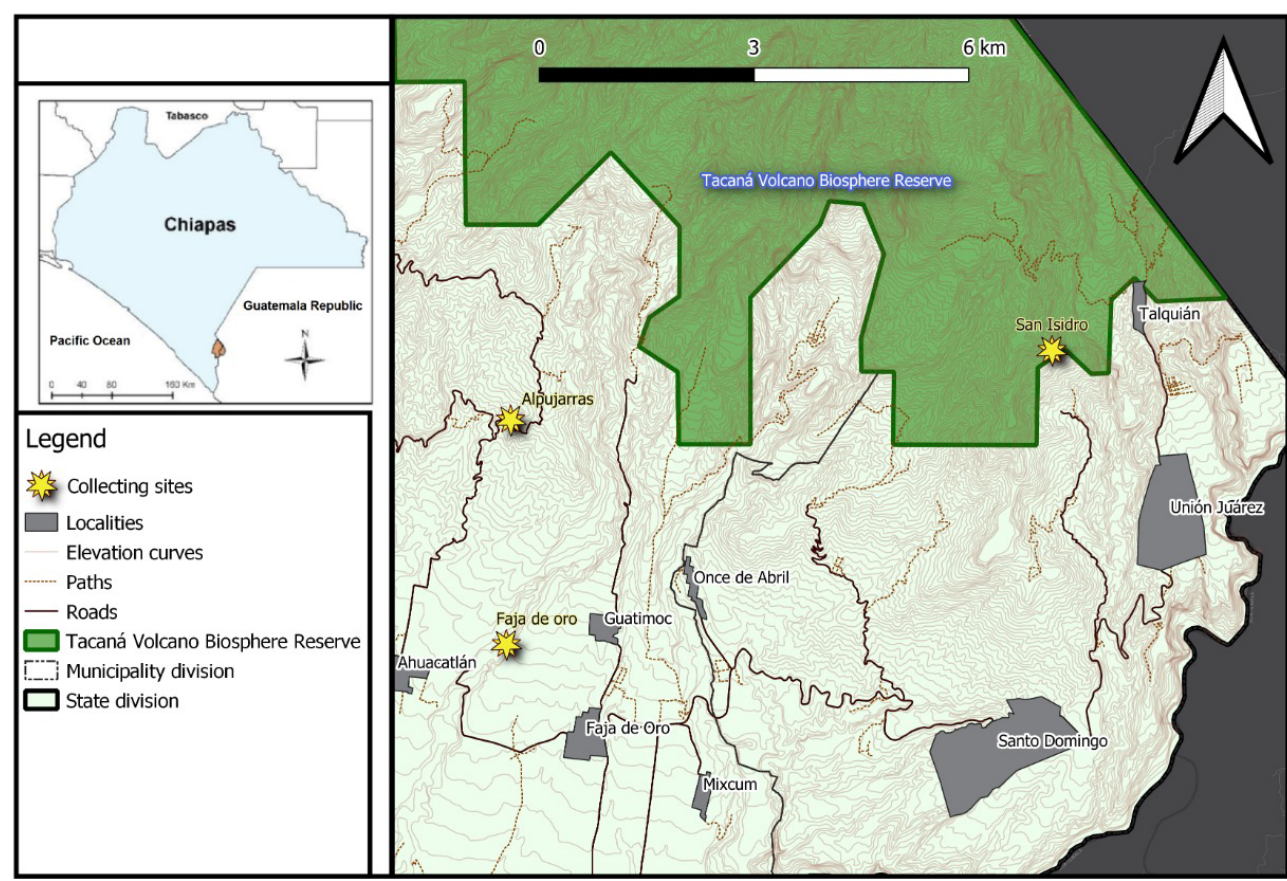
Figure 1. Map of Chiapas showing the Phonotimpus pennimani collecting sites. Yellow stars correspond to the collecting sites of Faja de Oro, Alpujarras (municipalities of Cacahoatán 14°59’29.49”N, 92°10’01.29”W; 986 m a.s.l.) and San Isidro (Unión Juárez 15°03’38.5”N, 92°04’54.77”W; 1701 m a.s.l.); the green area corresponds to the Tacaná biosphere